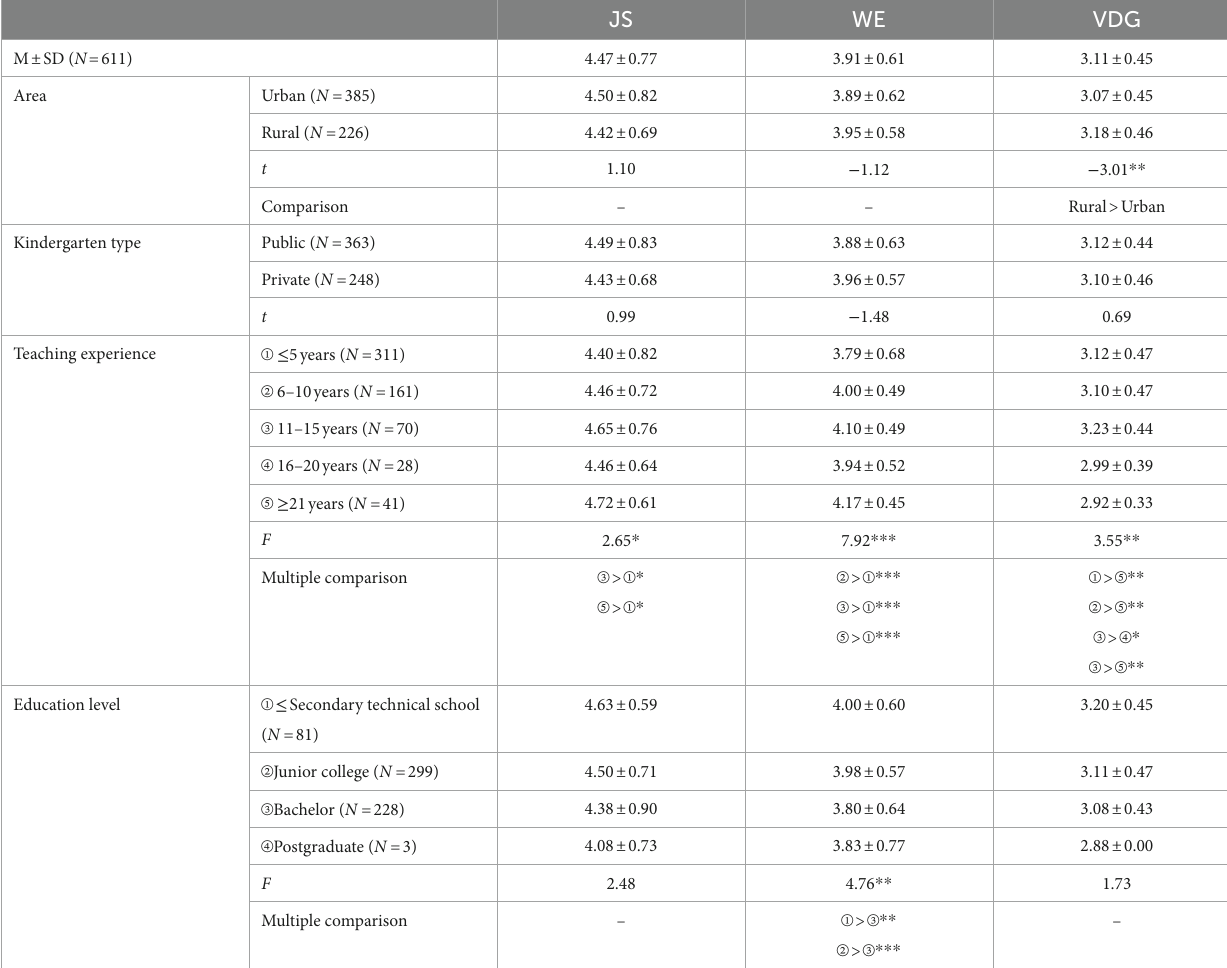
TABLE 5 Comparison of differences in demographic variables of each variable (M ± SD).